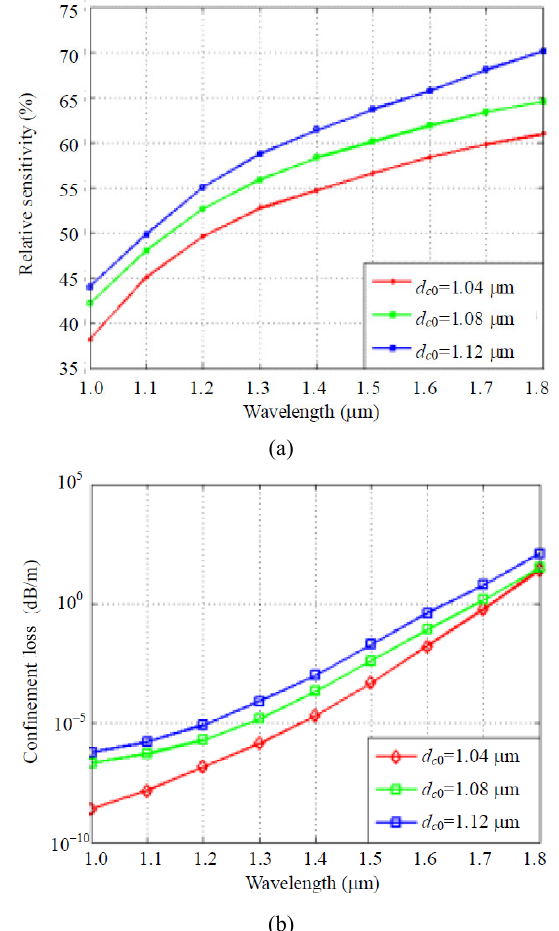
Fig. 8 Comparison between: (a) relative sensitivity versus wavelength and (b) confinement loss versus wavelength curve for the proposed H-PCF for optimized parameters:  = 3.00  m;  c = 1.08  m; d = 2.85  m, d c = 0.774  m, and d c 0 = 1.04  m, 1.08  m, and 1.12 μ m.